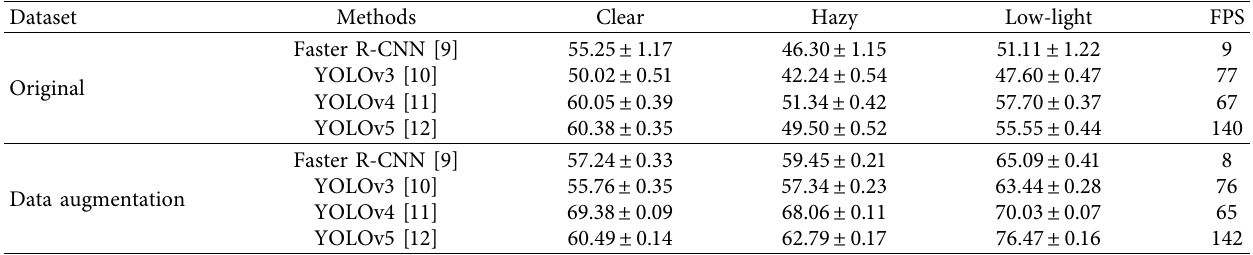
Table 1: The mean average precision (mAP) results of four bridge detection models trained with original dataset and enlarged dataset by data augmentation